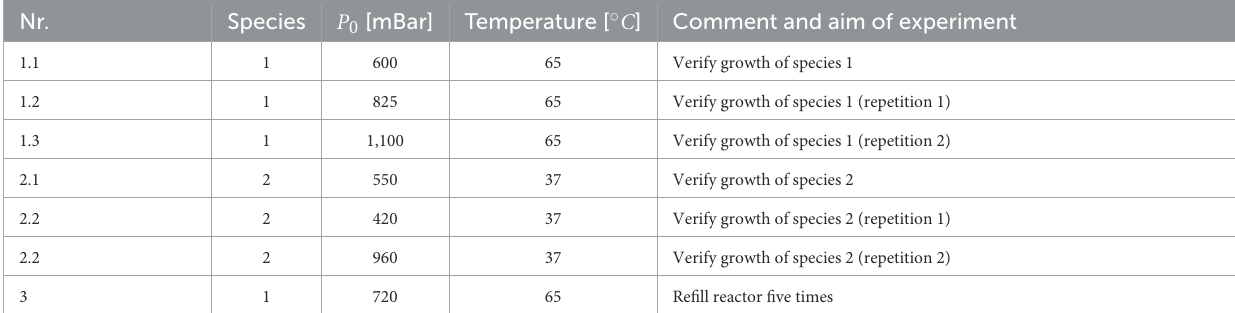
TABLE 1 Overview of the performed experiments relevant for the modeling part; marked series are considered for the modeling part.